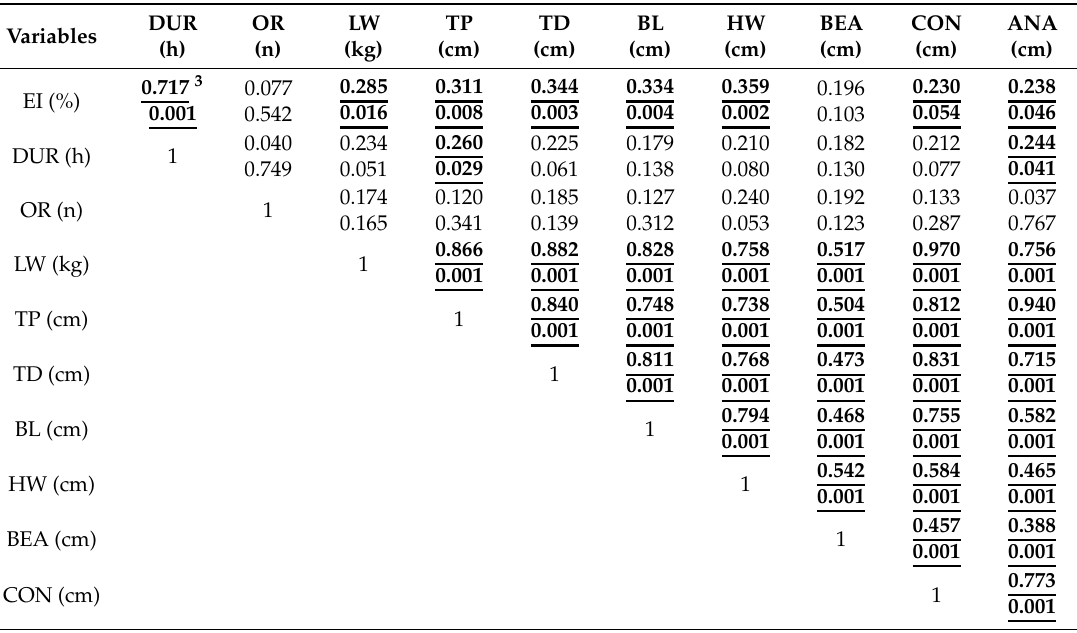
Table 3. Correlation coe ffi cient matrix between the response variables estrus induction (EI, %), duration of estrus (DUR, h), ovulation rate (OR, n), live weight (LW, kg), thoracic perimeter (TP, cm), thoracic diameter (TD, cm), body length (BL, cm), height at the withers (HW, cm), beard (BEA, cm), compactness index (CON, units), and anamorphosis index (ANA, units) in crossbred (Alpine-Saanen-Nubian x Criollo; n = 70) dairy goats managed under intensive conditions in Northern Mexico (March, 25 ◦ North) 1,2